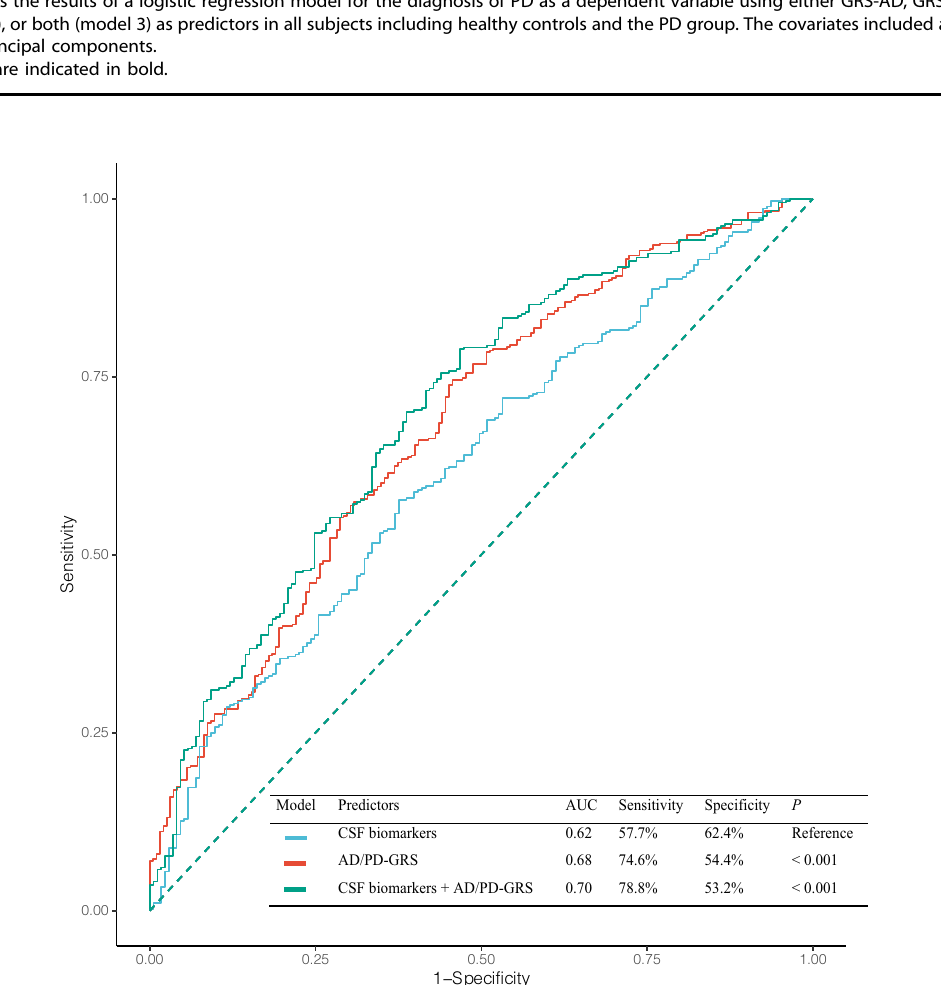
Fig. 1 Receiver operative characteristic curve analyses for prediction of PD. Data represent the results of receiver operative characteristic curve analyses for the diagnosis of PD using CSF biomarkers, GRS for AD and PD, or both as predictors. AD Alzheimer ’ s disease, AUC Area under the curve, CSF Cerebrospinal fl uid, GRS Genetic risk score, and PD Parkinson ’ s